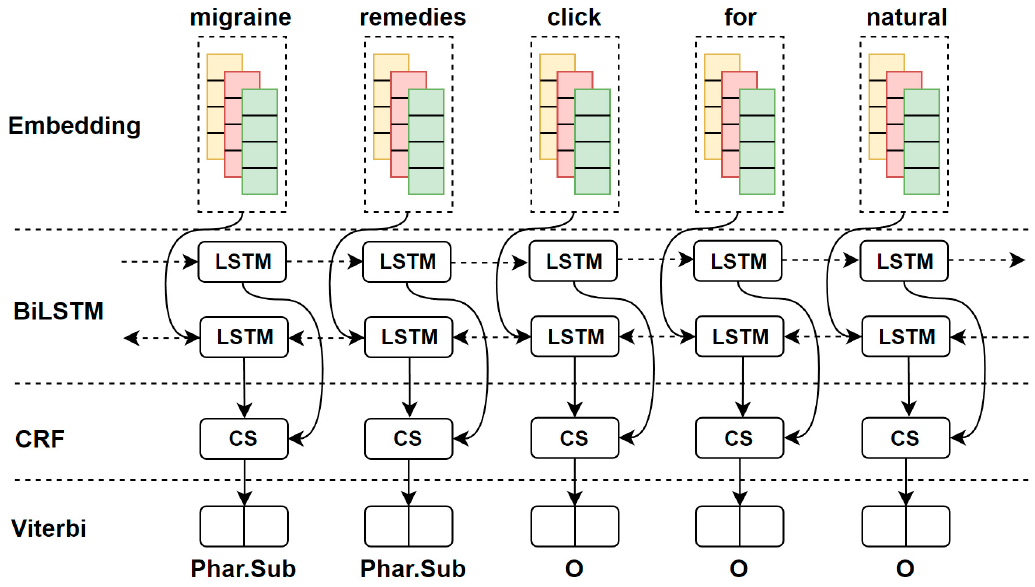
Figure 2. The BiLSTM-CRF model. CS: confidence score; BiLSTM: bidirectional long short-term memory; CRF: conditional random field.